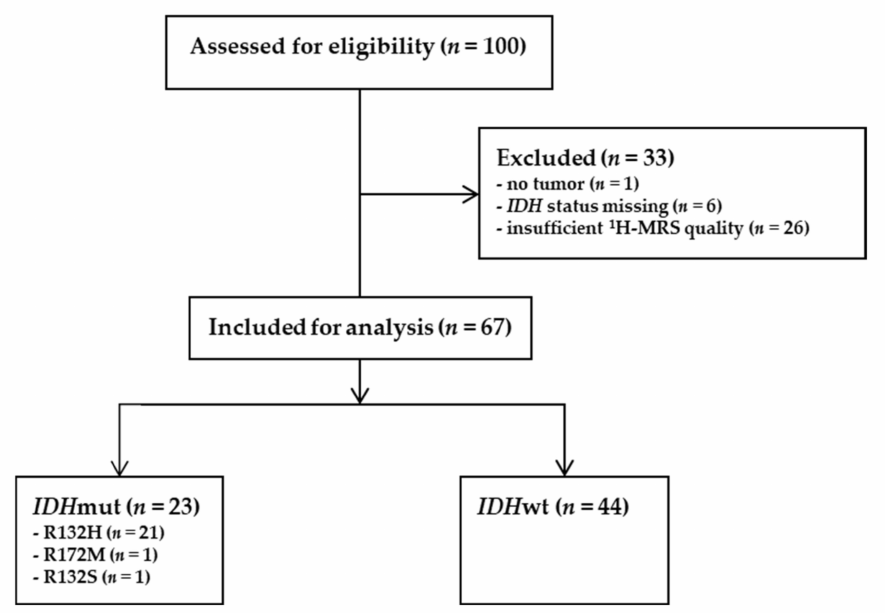
Figure 1. Overview of exclusion criteria and mutation status of 1 H-MR spectra. 1 H-MRS: proton magnetic resonance spectroscopy; IDH: isocitrate dehydrogenase ; mut: mutated; wt: